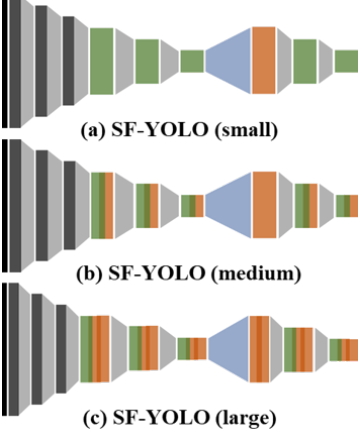
Figure 5. Expansion of SF-YOLO by replacing the scalable convolutional